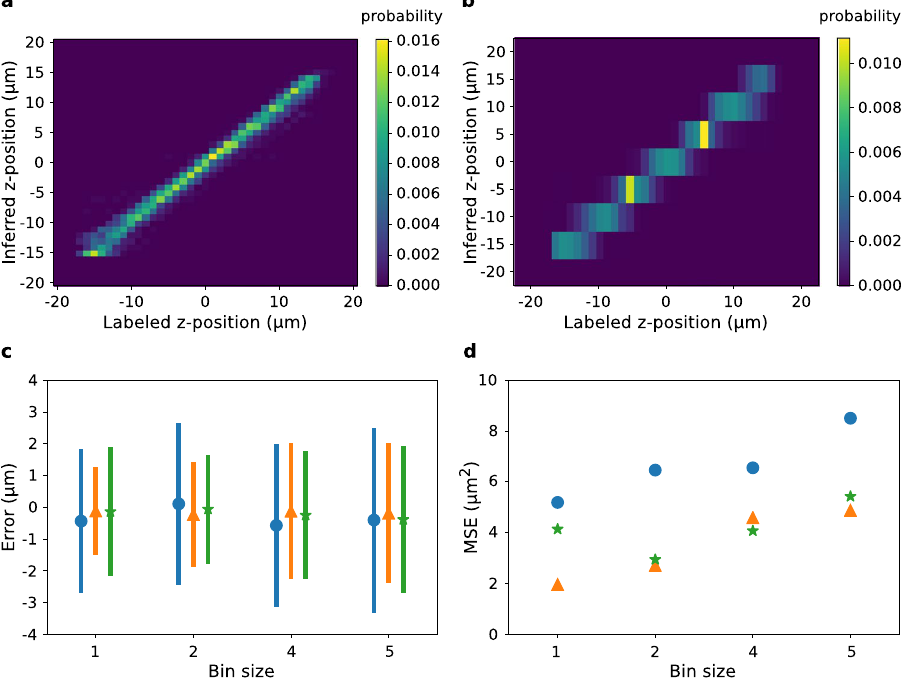
Figure 3. Accuracy of CNNs with different z-bin sizes. ( a,b ) The probability of inferring a z-position given the actual z-position using a CNN with a bin size of ( a ) 1 and ( b ) 5. ( c ) Error as a function of bin size. Symbols give the mean error and bars are ± 1 standard deviation. Blue dots, orange triangles, and green stars correspond to downsampling of 10X, 4X and 2X, respectively. A batch size of 50 was used for 10X and 4X downsampling, and batch size of 22 was used for 2X downsampling. ( d ) Mean squared error (MSE) vs. bin size.